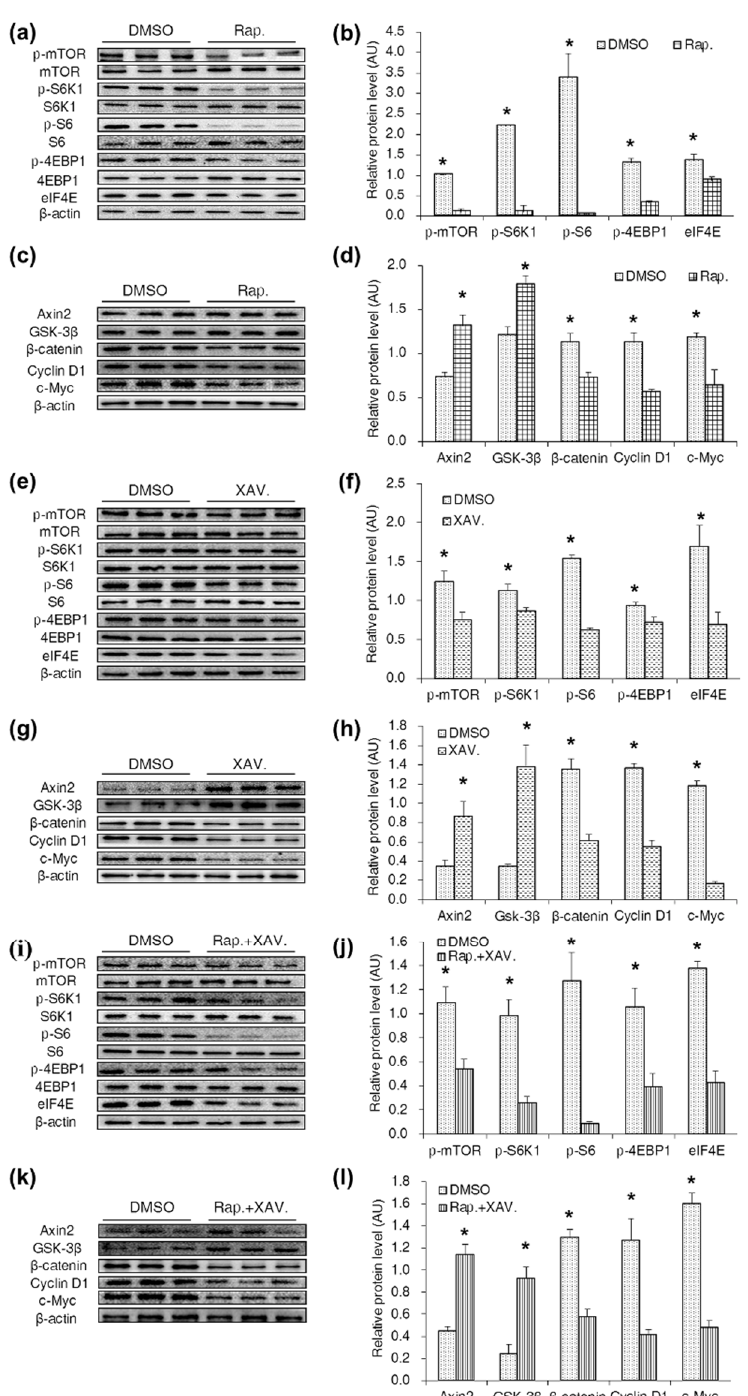
Figure 6. Specific antagonists inhibited both the mTORC1 and Wnt/ β -catenin pathways in CDX2 overexpressed IPEC-J2 cells. ( a – d ) Western blot analysis of the mTORC1 and Wnt/ β -catenin pathways activity after treated with rapamycin in CDX2 overexpressed IPEC-J2 cells with quantification ( n = 3); ( e – h ) western blot of the mTORC1 and Wnt/ β -catenin pathways related proteins after treated with XAV939 in CDX2 overexpressed IPEC-J2 cells with quantification ( n = 3); ( i – l ) protein levels of the mTORC1 and Wnt / β -catenin pathways were measured by Western blot after treated with rapamycin and XAV939 in combination with quantification ( n = 3). AU: arbitrary unit. As rapamycin and XAV939 were dissolved in DMSO, the DMSO-treated cell strain was the control group. DMSO: DMSO treatment group; Rap.: rapamycin treatment group; XAV.: XAV939 treatment group; Rap. + XAV.: combination of rapamycin and XAV939 treatment group. Representative results of three independent experiments are shown. Data are expressed as the mean ± SEM ( n = 3); * p < 0.05.